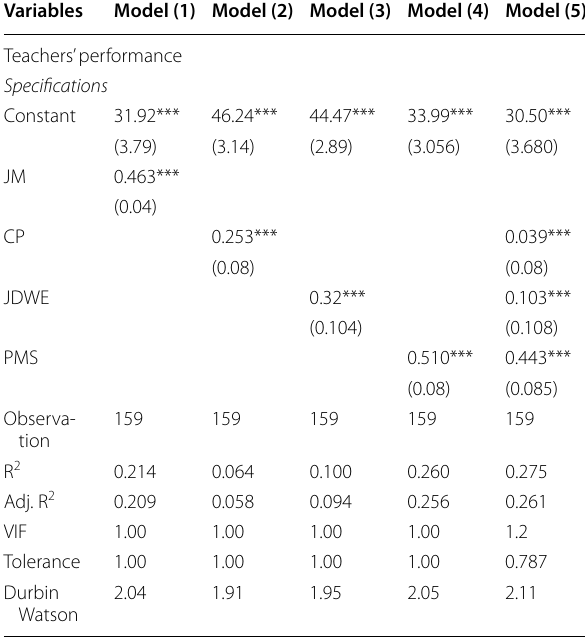
Robust standard errors in